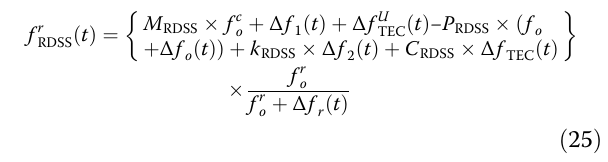
4 Method: precise time and frequency transfer